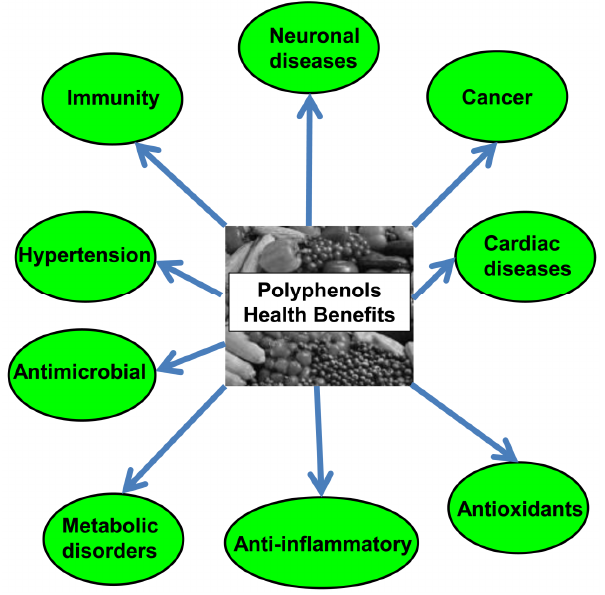
Figure 3. Overview summarizing the main health benefits of polyphenols. Polyphenols play key roles